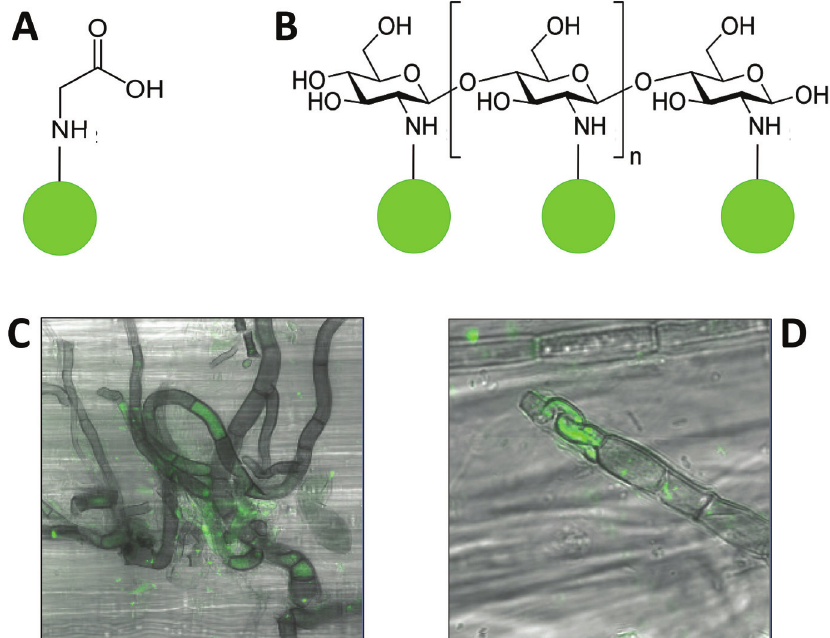
Fig 1. Configurations of QD-glycine (A) and QD-chitosan (B); and QD-chitosan in the interior of fungal hyphae from the N-fertilized community growing on N-fertilized litter (C), and control microbes on control litter (D). A, B: Each organic N compound was conjugated to a green QD via a strong covalent bond between the amino group in the organic N compound and the carboxyl group embedded in the shell of the QD. C, D: We examined each sample in a confocal microscope, and performed three-dimensional scans to verify that the QDs (green) were located in the interior of the hyphae.